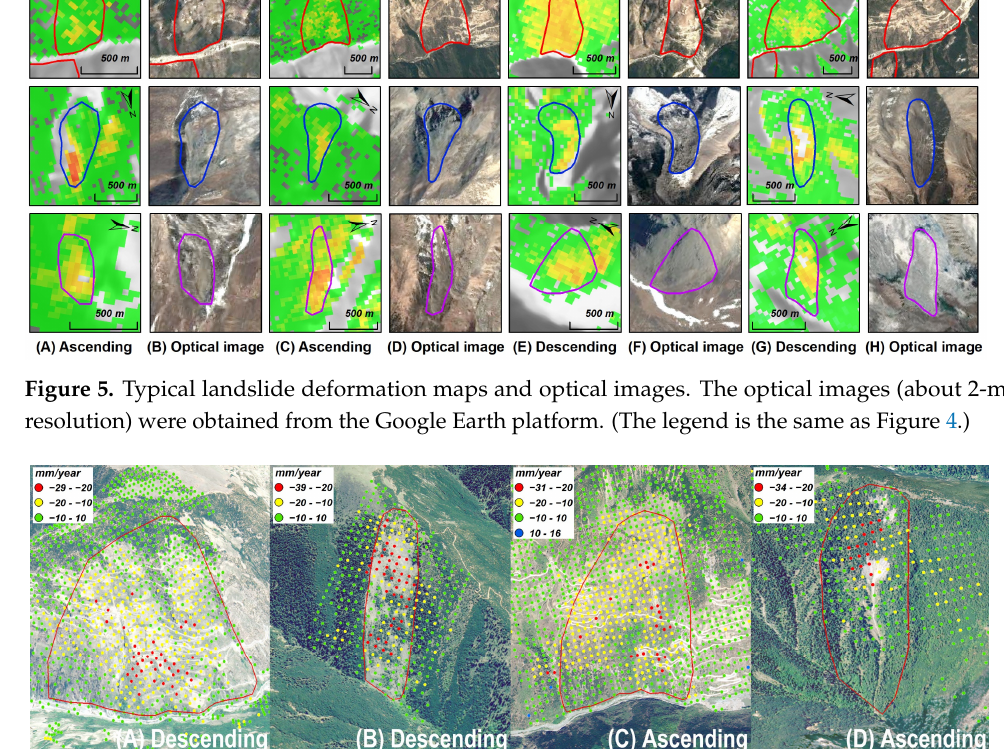
Figure 6. LOS velocity of typical slow-sliding rockslides. The base map is the Tianditu images with a spatial resolution of 1 meter. The red line represents the boundary of slow-sliding rockslides.